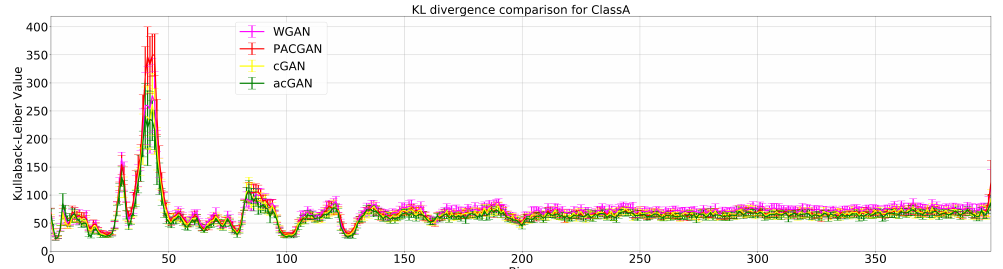
Figure 15. The KL comparison from class A data for the GAN models under test.